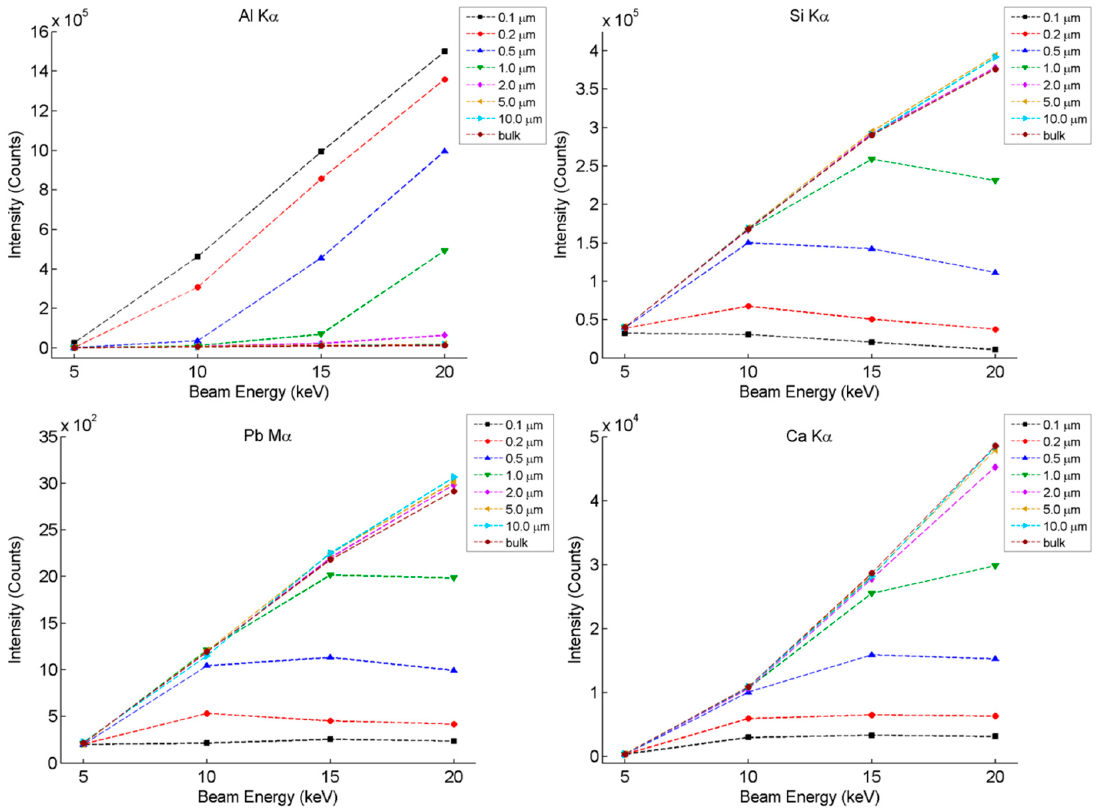
Figure 9. Simulated net X-ray intensities of the Al, Si, Pb and Ca emission lines of a spherical Egyptian blue pigment on an aluminum substrate, for different sample radii and electron beam energies (according to the scheme of Figure 7). The statistical variation for each point is of the order of 1%.